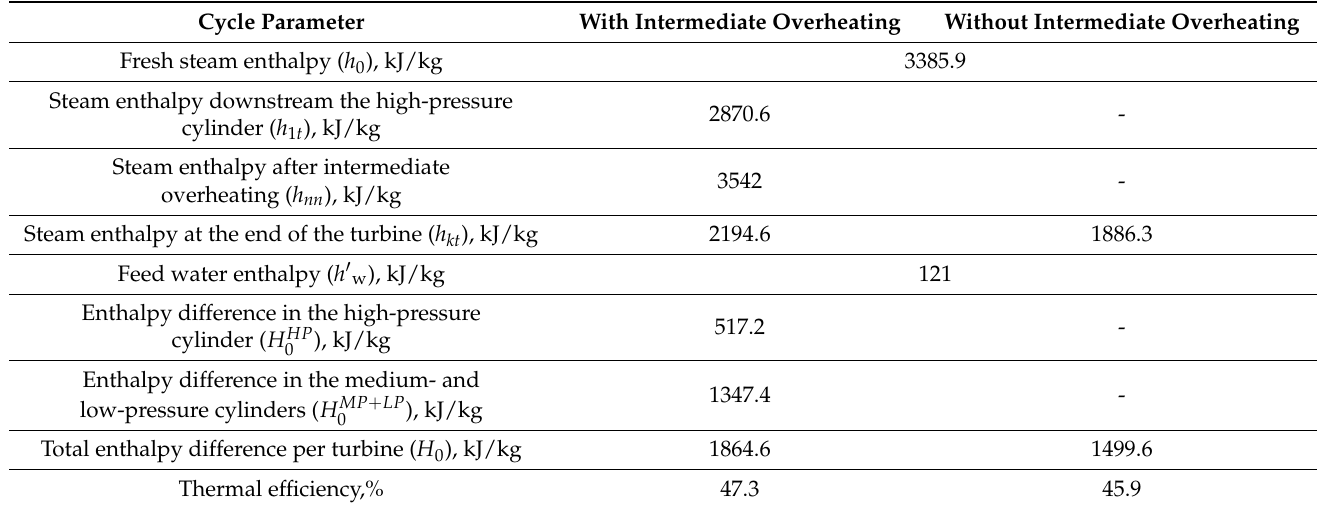
Table 6. Assessment of the effect provided by intermediate overheating on the thermal efficiency of the turbine